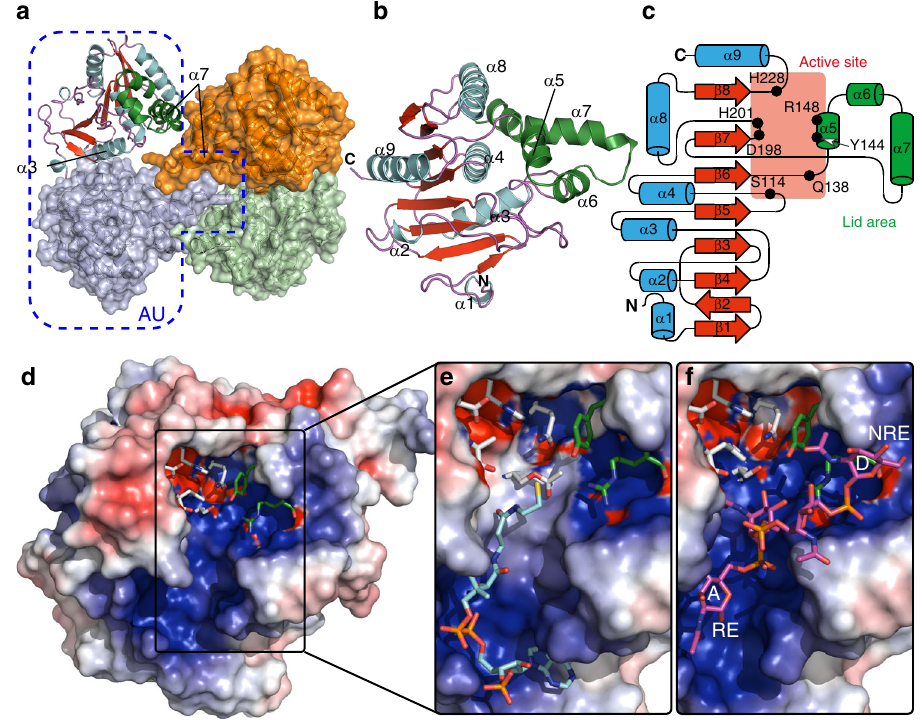
Fig. 4 Crystal structure of CsaC. a Tetrameric assembly of CsaC with the contents of the asymmetric unit in blue outline. b Secondary structure arrangement of the CsaC protomer. c Secondary structure topology map of CsaC protomer with important active site residues marked. d – f Electrostatic surface potential (blue — positive, red — negative, white — neutral) with active site residues in stick representation of ligand-free wild type CsaC protomer ( d ), acetyl-CoA-soaked CsaC-H228A ( e ), and CPS-DP4-soaked wild type CsaC ( f ). Pyranose ring A at the reducing end (RE) and pyranose ring D at the non-reducing (NRE) end of the CPS-DP4 are highlighted.